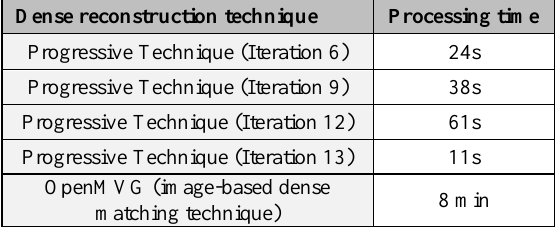
Table 2. The comparison between the required processing time in successive iterations of the proposed progressive technique and an available image-based dense reconstruction technique